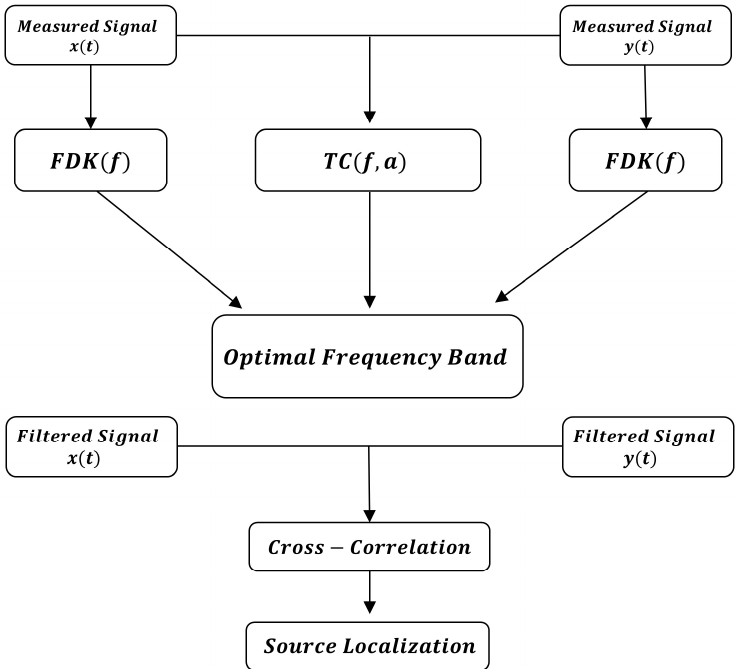
Figure 11. Impact-damage detection algorithms.